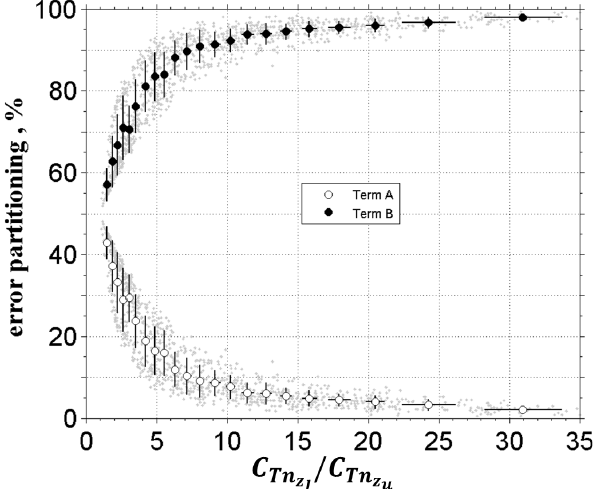
Fig. 13. The error partitioning of term A and B in Eq. (4) as a func- /C Tn tion of the C Tn ratio for the entire data set (51 days) in- z l z u cluding all inlet height arrangements (block 1–3) and heights ( z 1 , z 2 , z 3 )